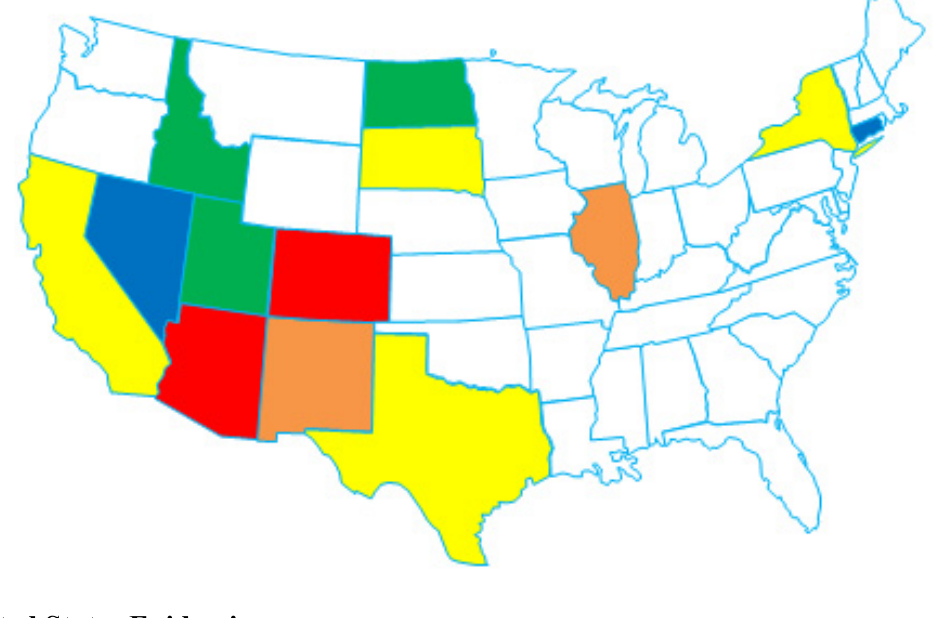
Figure 3. Map of the United States showing states with the SW/WN03 genotype. Colors refer to year that the SW/WN03 genotype was first identified from isolates collected in a particular state. Red = 2003, orange = 2004, yellow = 2005, green = 2006, and blue =